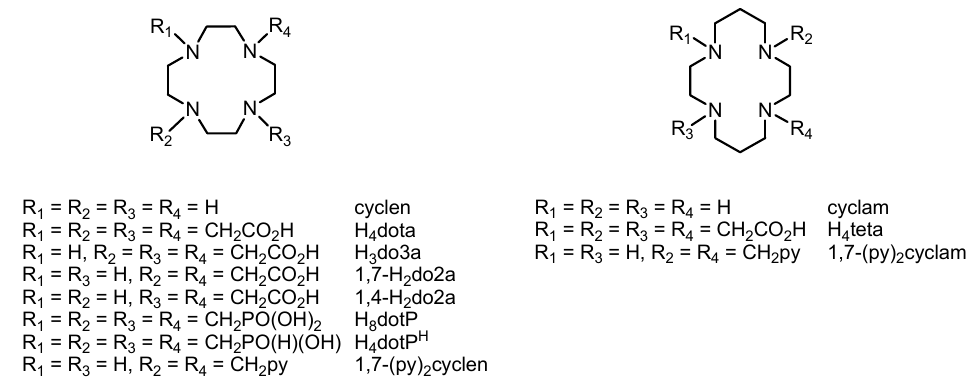
Figure 1. Structural representations and abbreviations of selected macrocycles derived from cyclen ( left ) and cyclam ( right